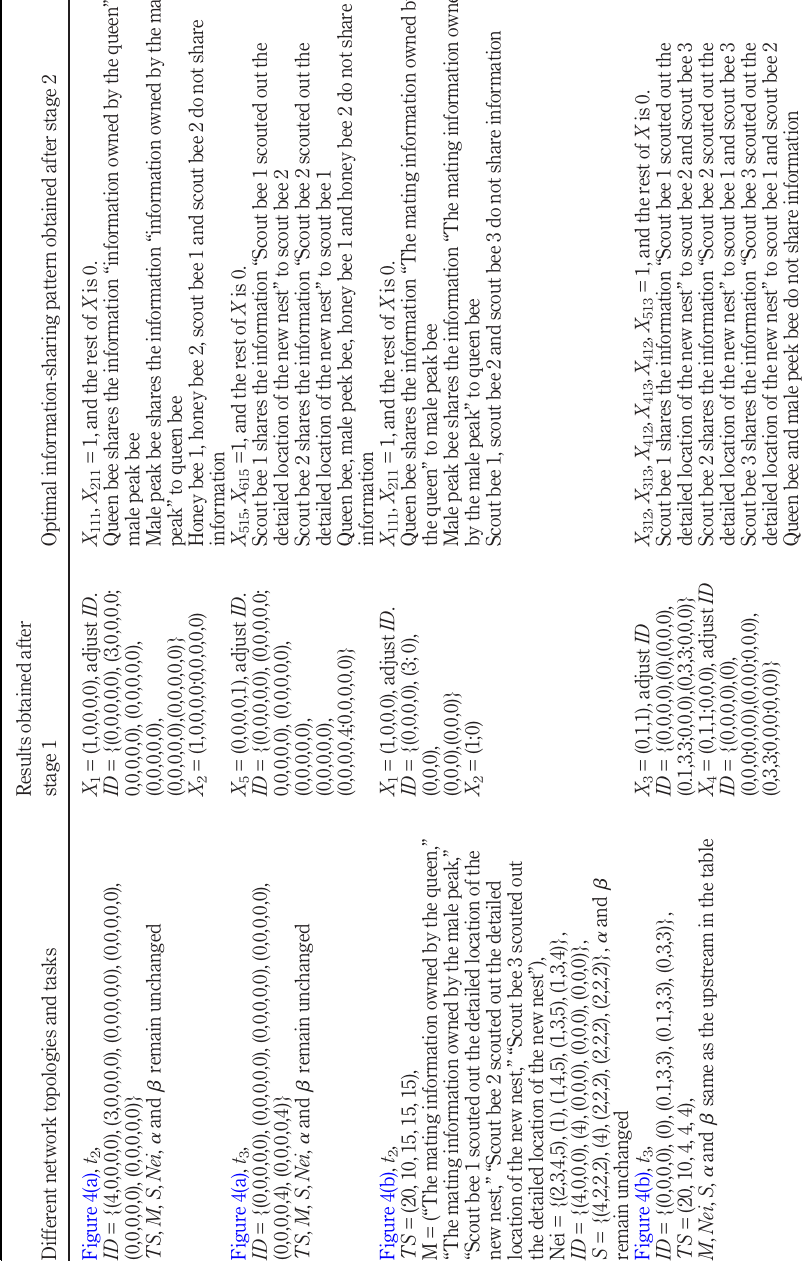
Table I. The optimal information-sharing pattern for different network topologies and tasks in bee